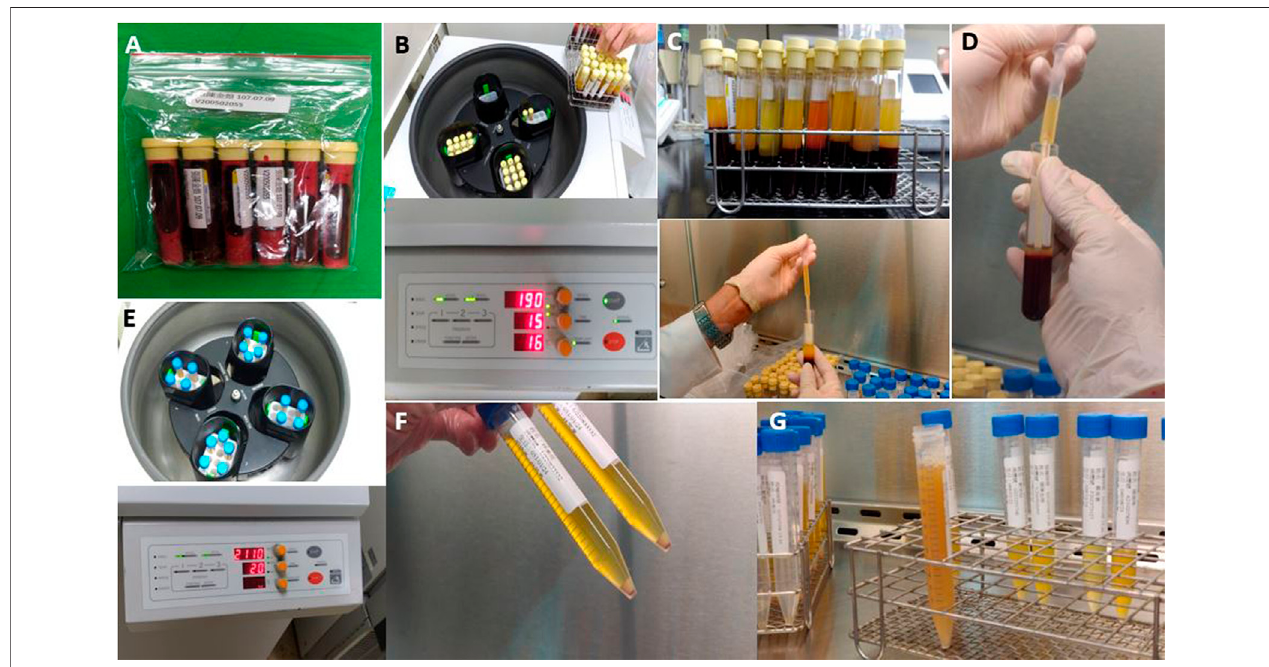
FIGURE 1 | Preparation of platelet-rich plasma. (A) A total of 100 ml of whole blood was withdrawn; (B) Initial centrifugation of the blood with a soft spin (190 ×g, 20 min, < 20 ° C); (C) The supernatant plasma containing platelets; (D) Supernatant plasma was transferred to another sterile tube without disturbing buffy coat; (E) The plateletcontainingplasmawasfurthercentrifugedviaahardspin(2000×g,20 min, < 20 ° C); (F) Plateletpelletswereformedatthebottomofthetube; (G) Theprecipitate was platelet-rich plasma (PRP) and the upper part was platelet-poor plasma (PPP). After the PPP was removed, the platelet pellets were added to the required volume of PPP or normal saline to form sterile PRP for